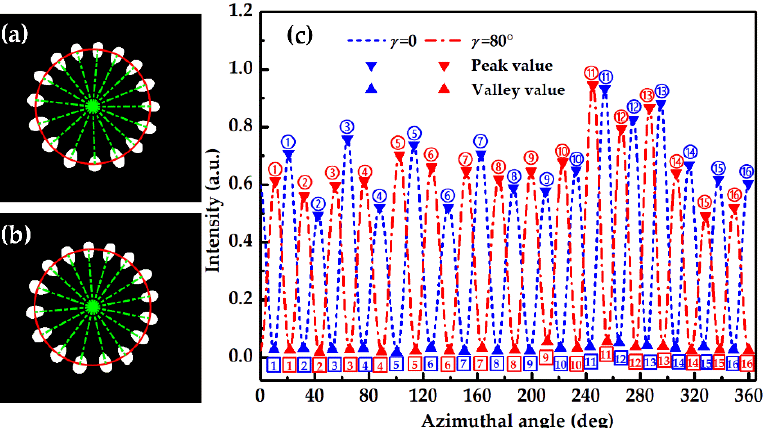
Figure 6. Processed experimental results. ( a ) γ = 0°; ( b ) γ = 80°; ( c ) intensity curves on the red cycles for γ = 0° and 80°, respectively.